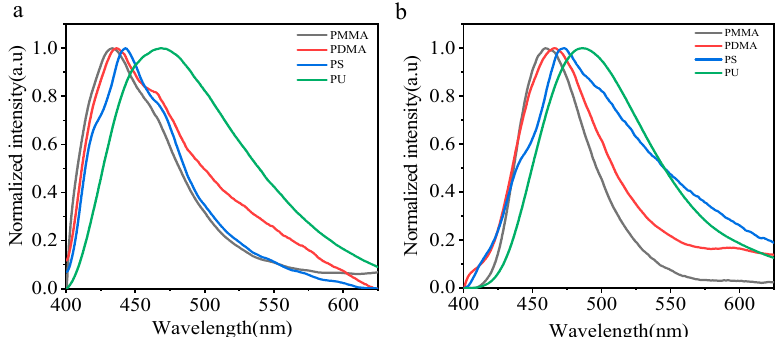
Figure 6. Steady-state emission spectra of CZ-NI-OH ( a ) and CZ-NI-SH ( b ) dispersed in different polymer matrices .